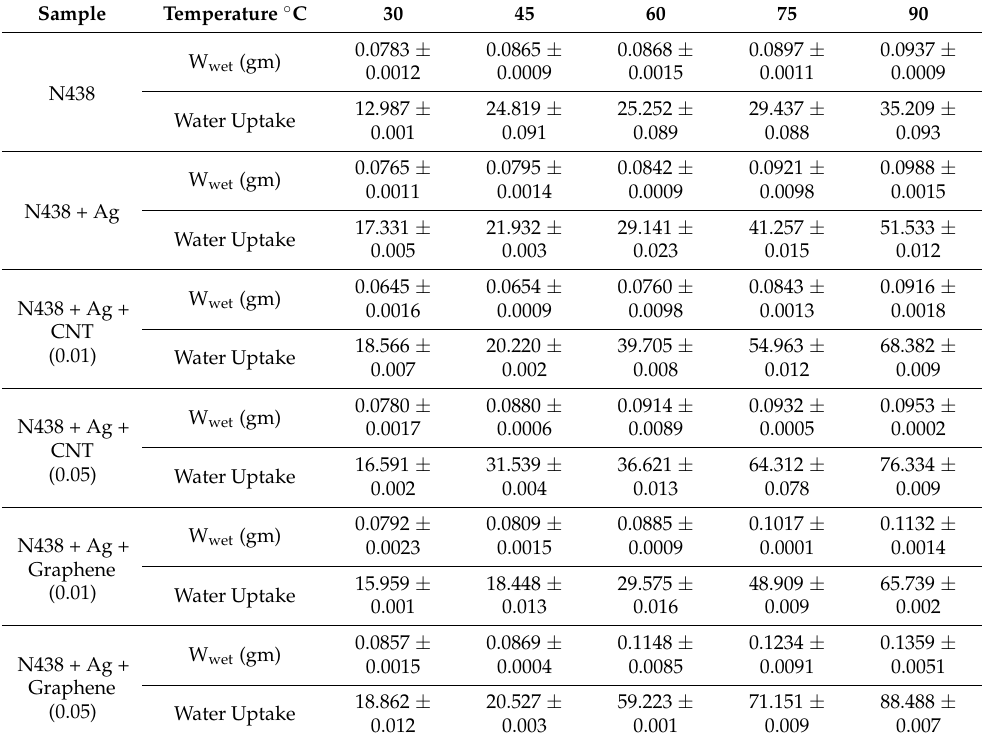
Table 4. Weight of the Samples after immersion in hot water and their respective water uptake.